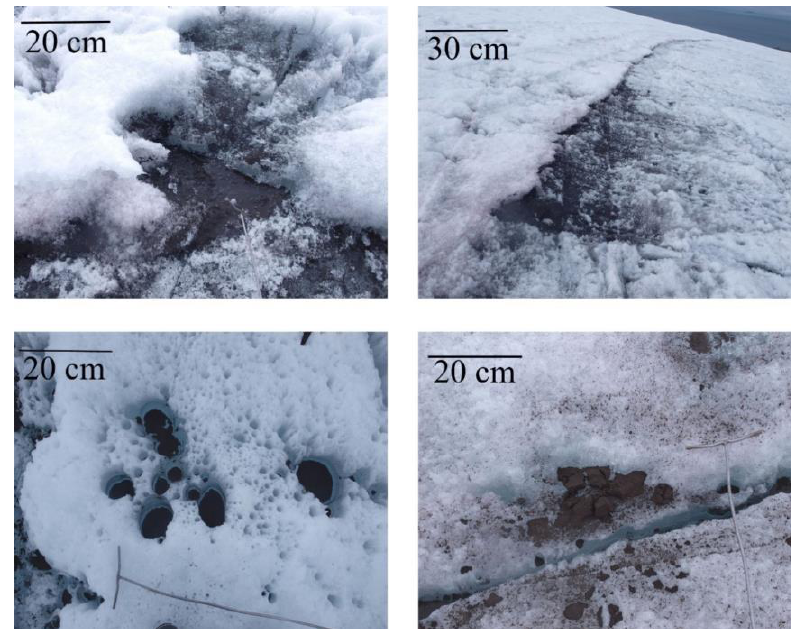
Figure 2. Studied cryoconites from Collins Ice Cap, King George Island, Antarctica.